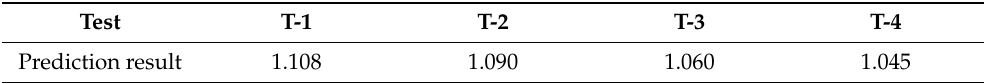
Table 7. Safety factor prediction results of the model